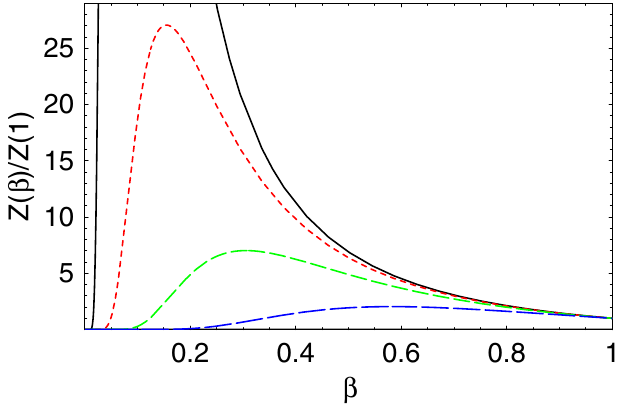
FIG. 2. (Color) The same, for a small semispherical